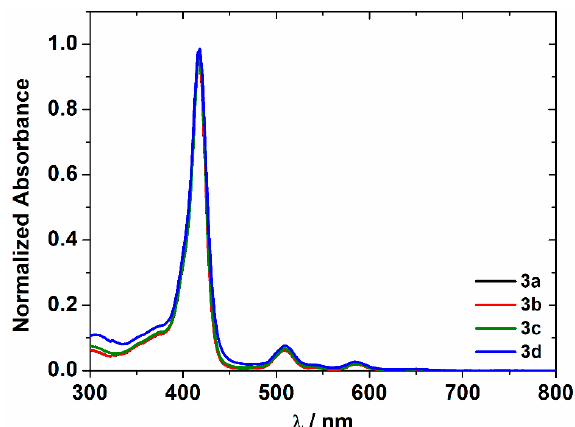
Figure 1. Normalized UV-vis absorption spectra of thioaryl-porphyrins 3a – d containing different substituent groups in CHCl 3 solutions.